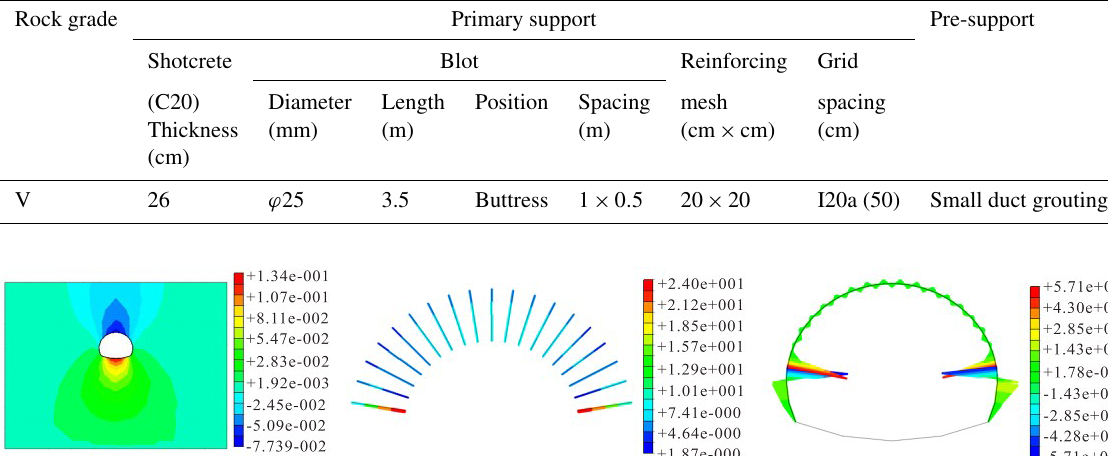
Figure 4. Working Condition 1: vertical displacement of the surrounding rock (mm), moment of shotcrete (KNm), and axial force of the anchor rod (KN).